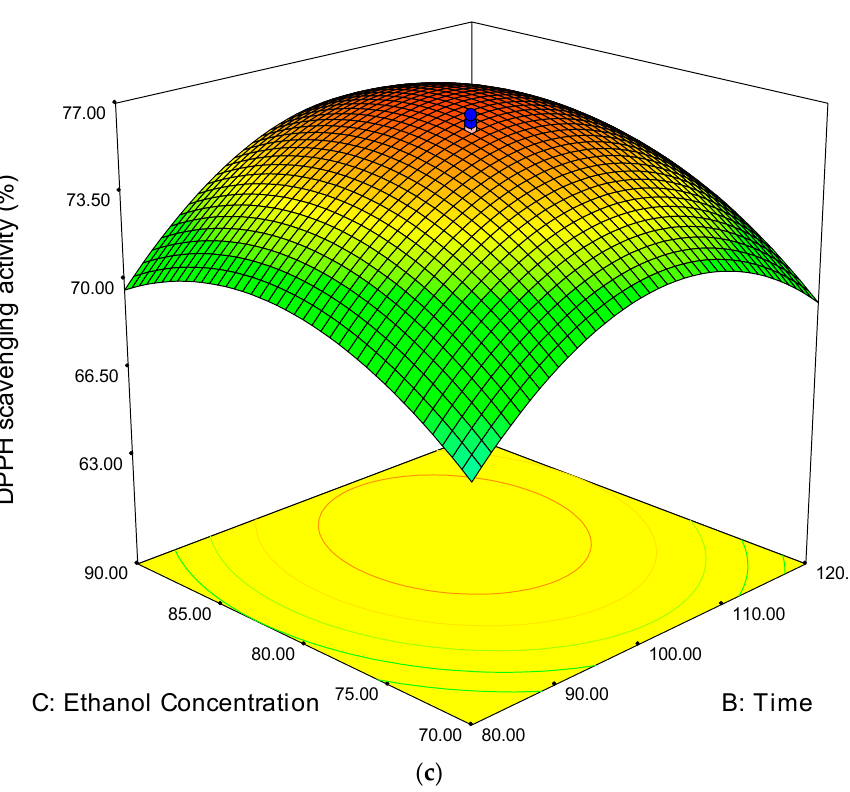
Figure 1. The response surface (3D) and contour plots showing the effect of extraction temperature and time ( a ); temperature and ethanol concentration ( b ); extraction time and ethanol concentration ( c ) on the DPPH scavenging activity of the red pitaya peels.